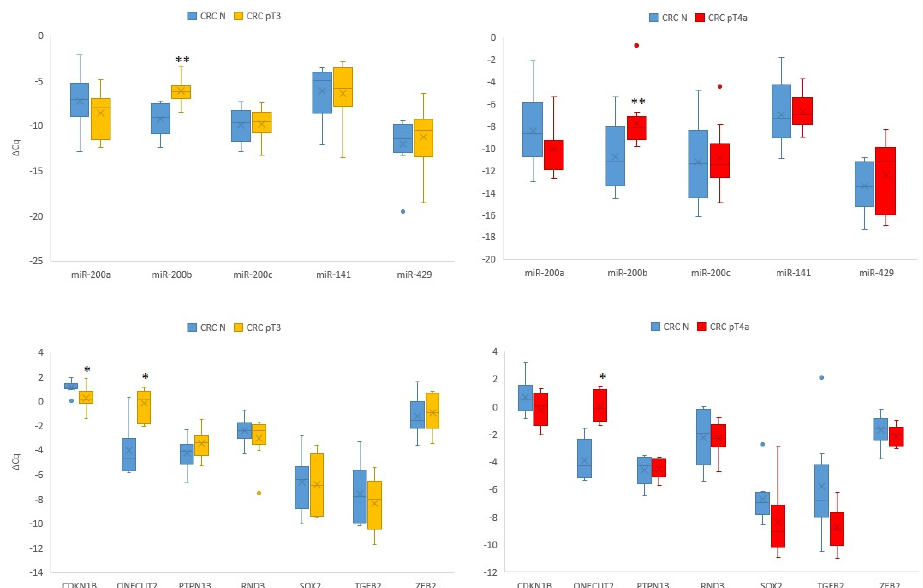
Figure 2. Expression of the miR-200 family and their target genes in CRC pT3 and CRC pT4a in comparison to corresponding normal mucosa. Abbreviations: CRC, colorectal carcinoma; Δ Cq, delta